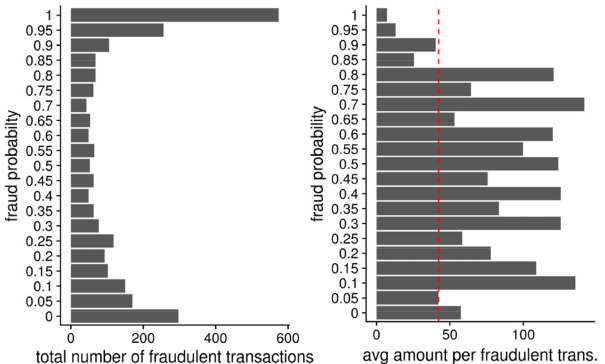
Figure 10. Comparing the total number and average amount of fraudulent